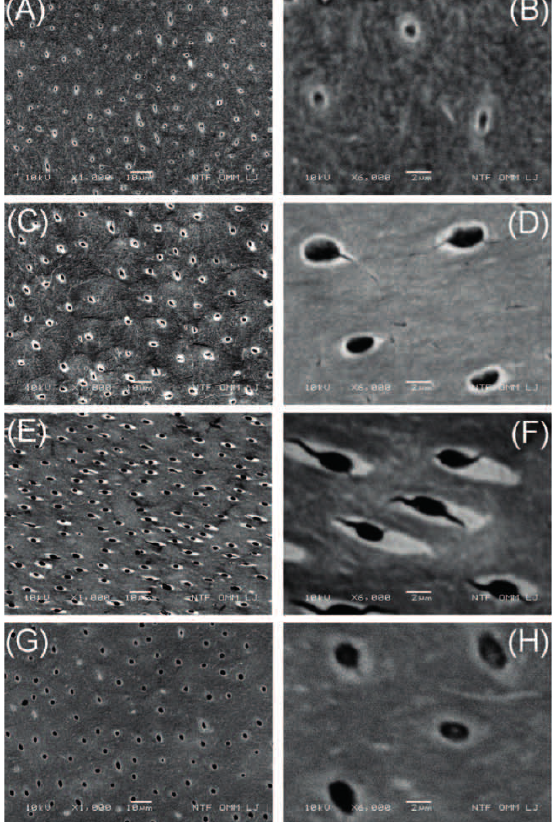
Figure 2. Dentin microstructure of cross-sections from the middle of the bulk of dentin as observed under scanning electron microscopy (SEM) in backscatter electron mode (BSE) of (A, B) canine, (C, D) porcine, (E, F) equine and (G, H) hu- man dentin. In all species better mineralization of PTD than ITD is present. (A, B) In canine dentin DT are signifi cantly smaller and surrounded by narrower PTD area comparing to PTD in other species. Additionally, in canine dentin den- sity of DT per mm 2 was notably lower. (E, F) Equine dentin shows typical shape of oval PTD. On higher magnifi cation uneven diameter of PTD is clearly seen. Density of DT per square plane and DT diameters of (C, D) porcine and (G, H) human dentin are very similar. Photomicrographs (A, C, E and G) and (B, D, F and H) are taken at magnifi cation of 1000x and 6000x, respectively. DT, dentinal tubules; ITD, intertubular dentin; PTD, peritubular